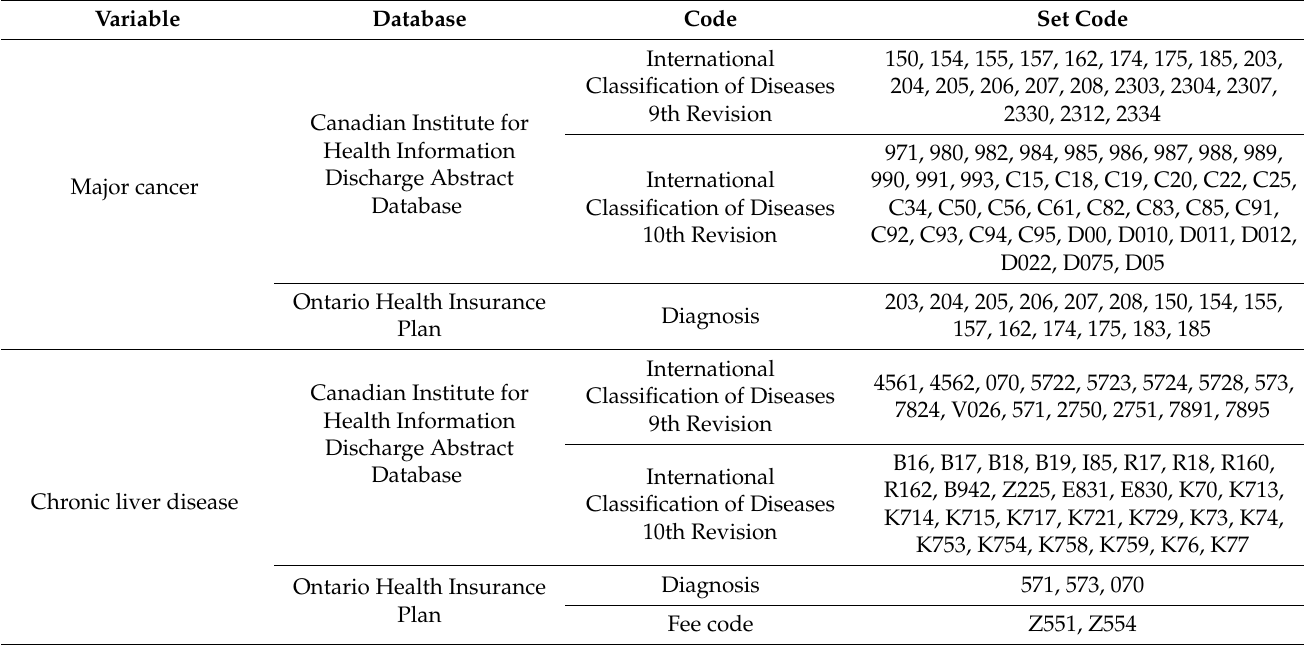
Table A2. Coding definitions for comorbid